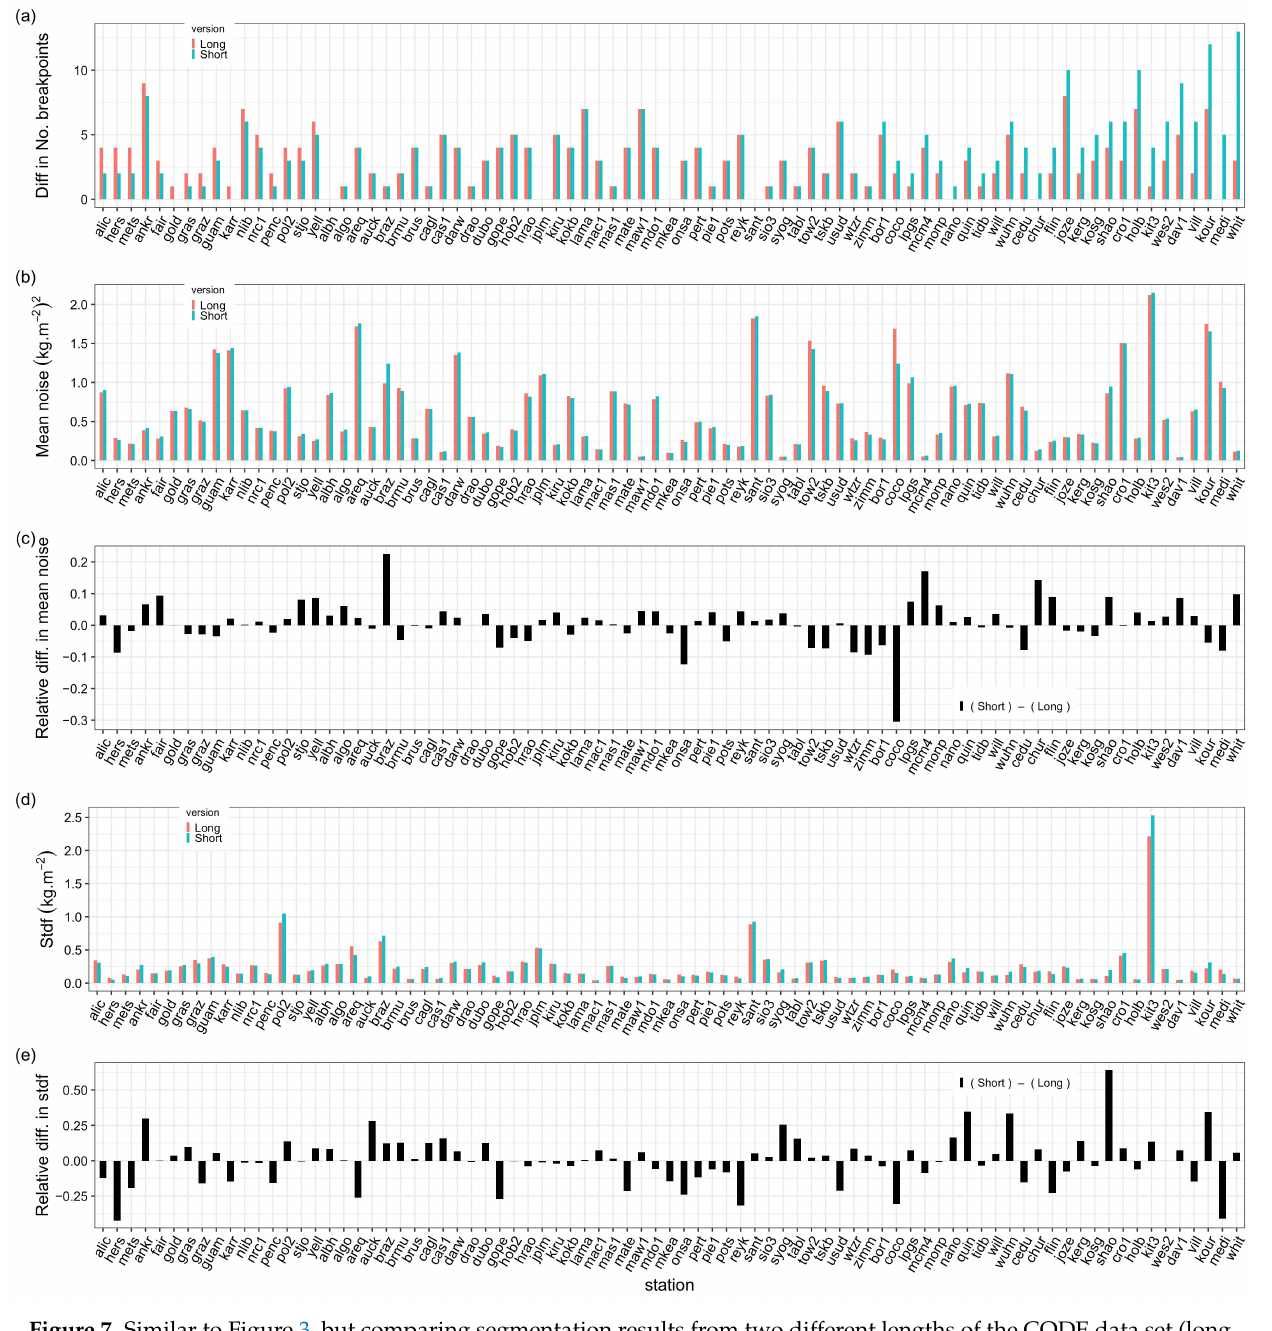
Figure 7. Similar to Figure 3, but comparing segmentation results from two different lengths of the CODE data set (long time series, from 1994 to 2018, short time series, from 1994 to 2010). The mean noise and standard deviation of the functional (stdf) are representative of the full times series, but the number of breakpoints are counted in the common period only